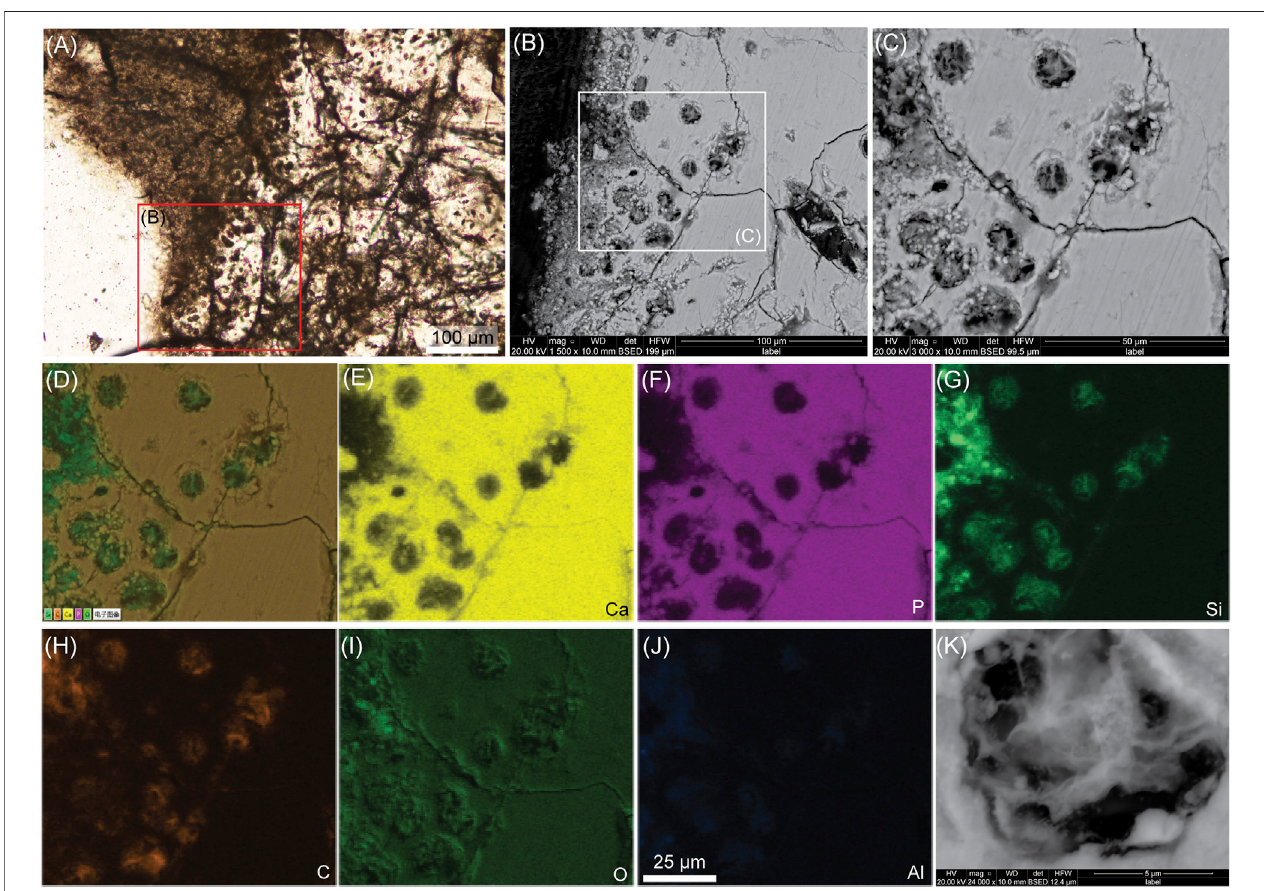
FIGURE 4 | Another ground-section with SEM and EDS analyses of the cartilage on the furcula of Confuciusornis (IVPP V11521). (A) High-magni fi cation light microscopy image of furcular calci fi ed cartilage. (B) SEM image of the red square in A showing chondrocyte lacunae. (C) Close-up on the chondrocyte lacunae in (B) . It reveals fi lamentous material inside the lacunae. (D) EDS mapping of the fi ve main chemical elements in (C) . (E) – (J) are EDS mapping of the individual elements calcium (Ca), phosphorous (P), silicon (Si), carbon (C), oxygen (O) and aluminum (Al). (K) High-magni fi cation SEM image on one chondrocyte lacuna, showing a chondrocyte with a fi lamentous morphology, some granular areas and a small circular structure in the center. The scale bar is the same from (D) through (J) .